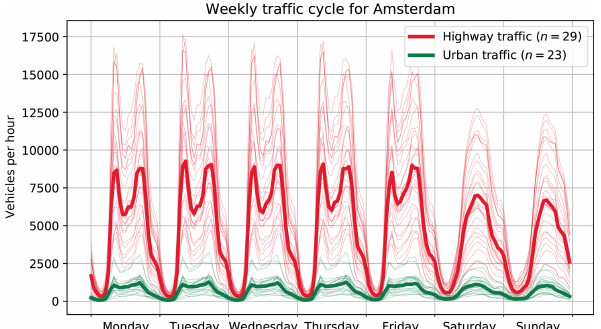
Figure 3. Weekly cycle of highways and urban roads at counting locations (thin lines), aggregated from hourly data from 2016. The thick lines show the median of traffic flow for both road types. The morning and evening rush hours on working days are clearly visi- ble for highways. Urban traffic has, apart from lower volume, less distinct